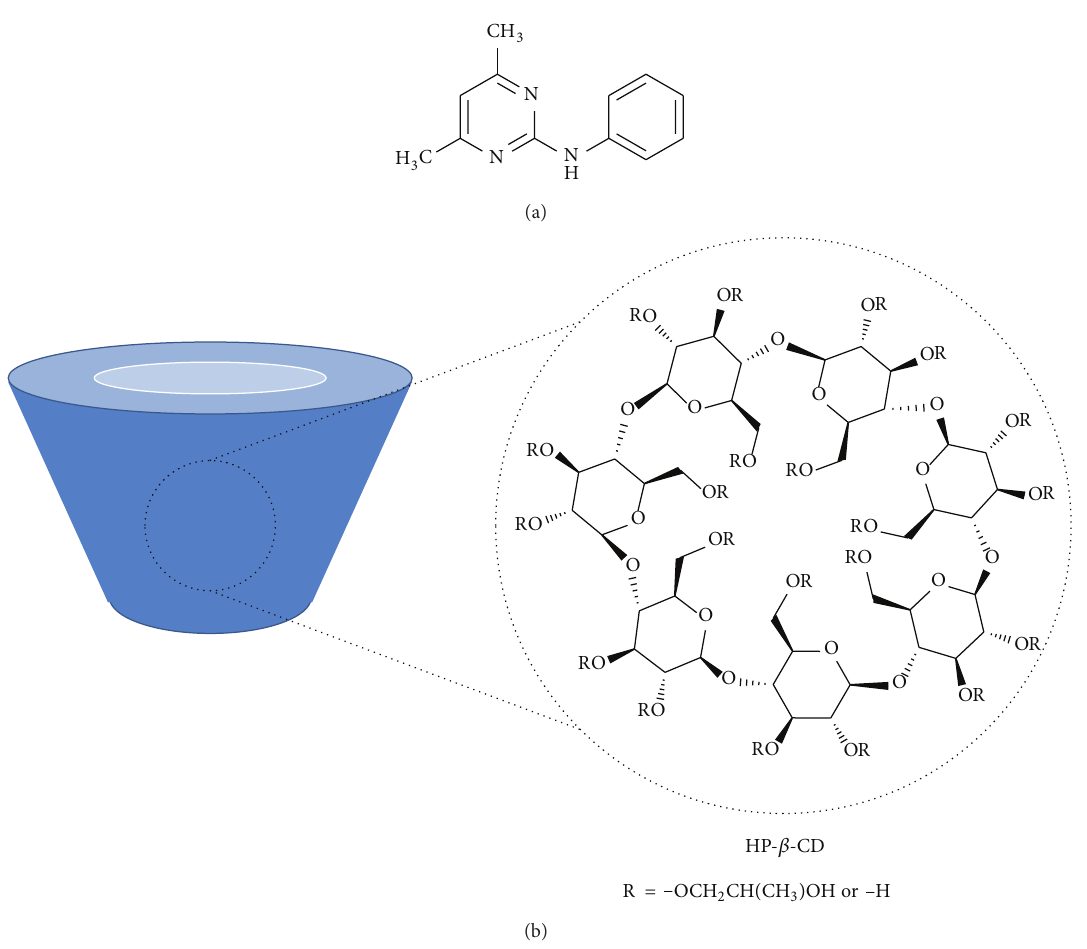
Figure 1: Schematic representation of (a) chemical structure of pyrimethanil and (b) 3D structure of (2-hydroxypropyl)- 𝛽 -cyclodextrin (HP- 𝛽